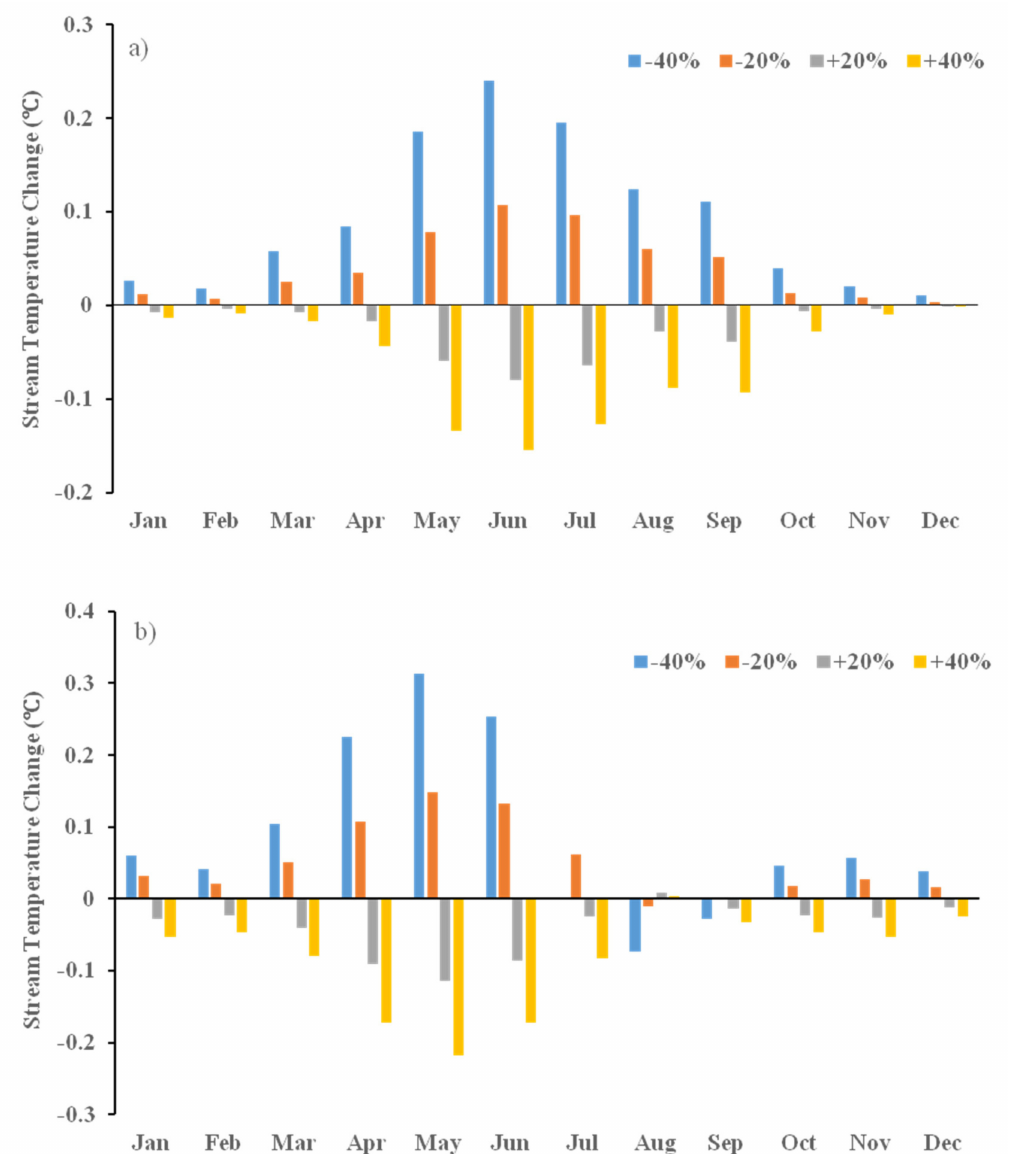
Figure 6. Stream temperature sensitivity to di ff erent runo ff components in the ERW: ( a ) surface runo ff change and ( b ) snow melt